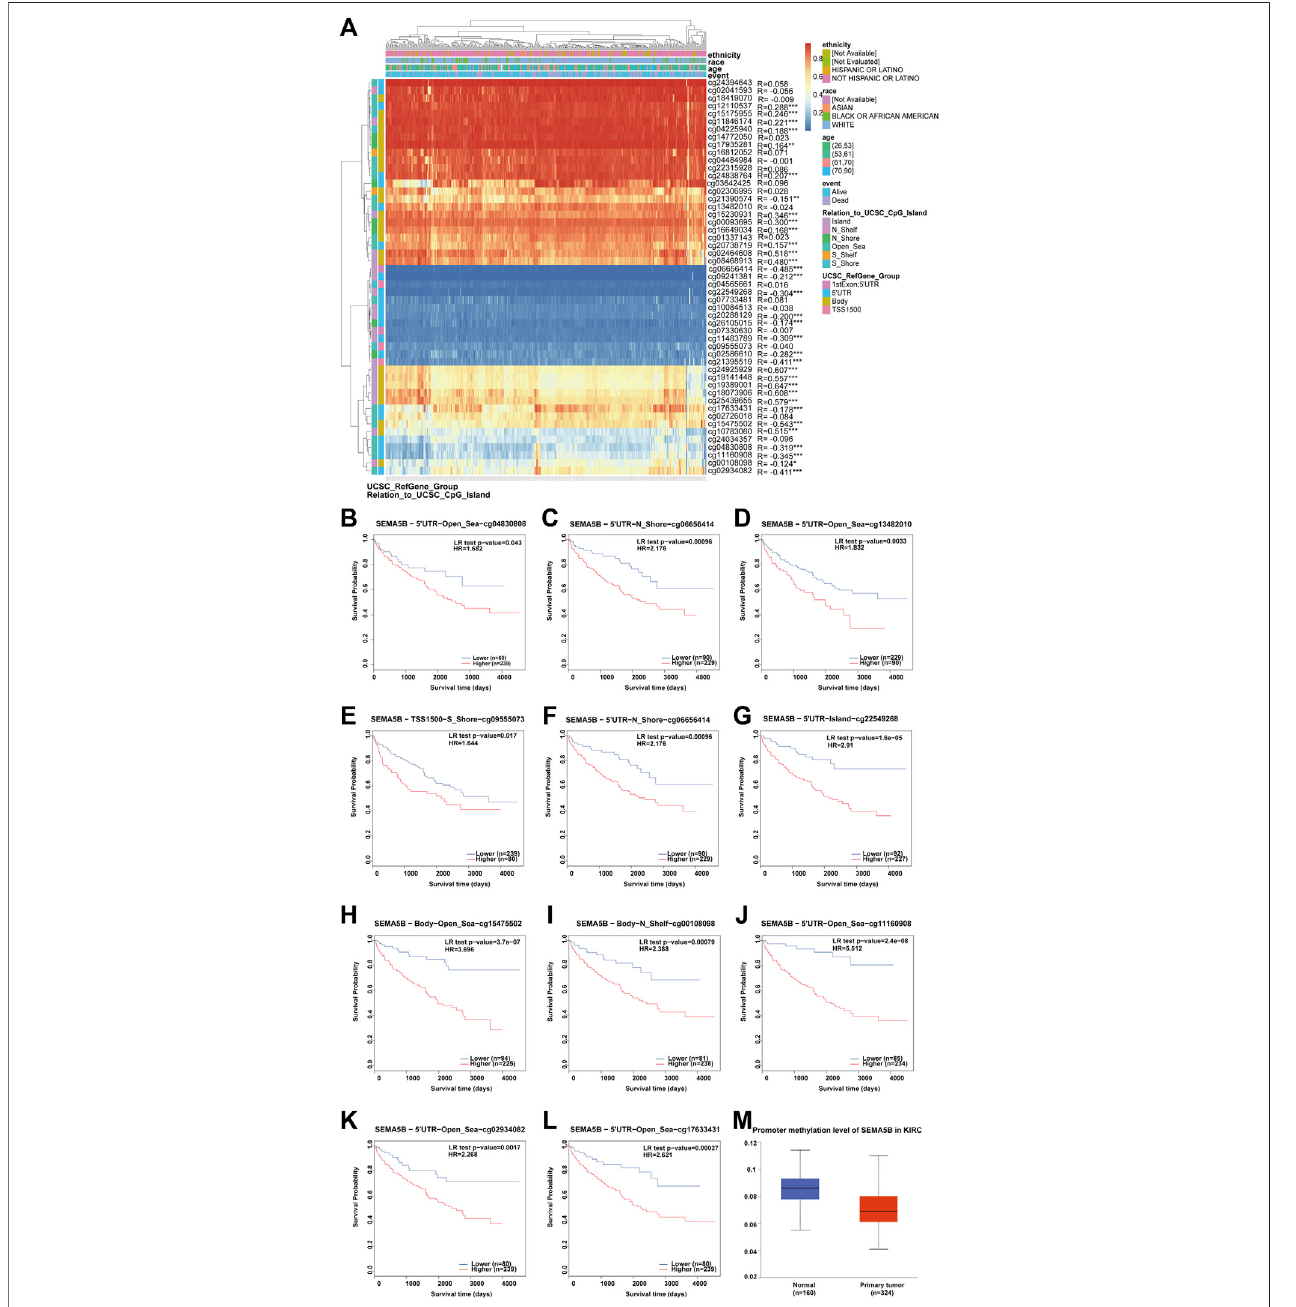
FIGURE 8 | Analysis of SEMA5B methylation in KIRC. (A) Heat map of the methylation level of the SEMA5B gene. The correlations between SEMA5B methylation and its expression were analyzed. p < 0.05 was considered statistically signi fi cant. * p < 0.05, ** p < 0.01, *** p < 0.001. (B – J) Survival analysis based on methylation at multiple sites. (M) The promoter methylation level of SEMA5B in